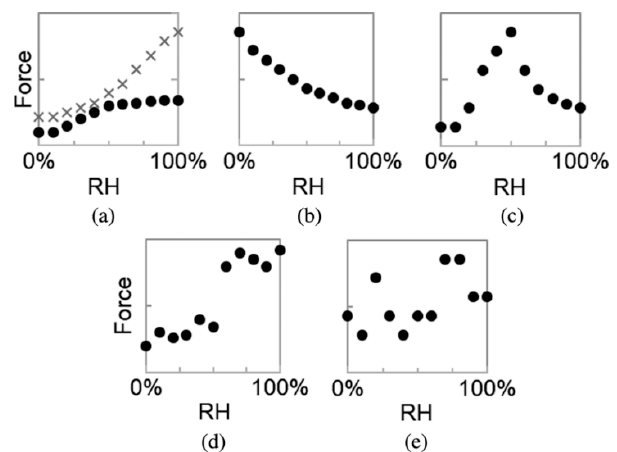
Figure 10. Possible trends of adhesion force versus RH curves in AFM measurements. ( a ) Monotonic increase (two different types); ( b ) Monotonic decrease; ( c ) Increasing to maximum and then decreasing; ( d ) Step-wise increase; and ( e ) RH independence. Reprinted from Ref. [15], Copyright 2015, with permission from Taylor &